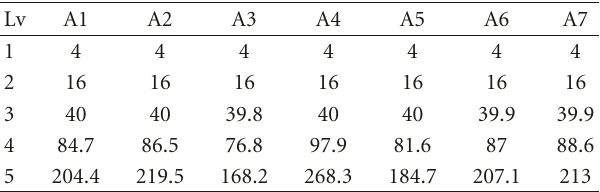
Table 7: Average number of bins at each resolution level.